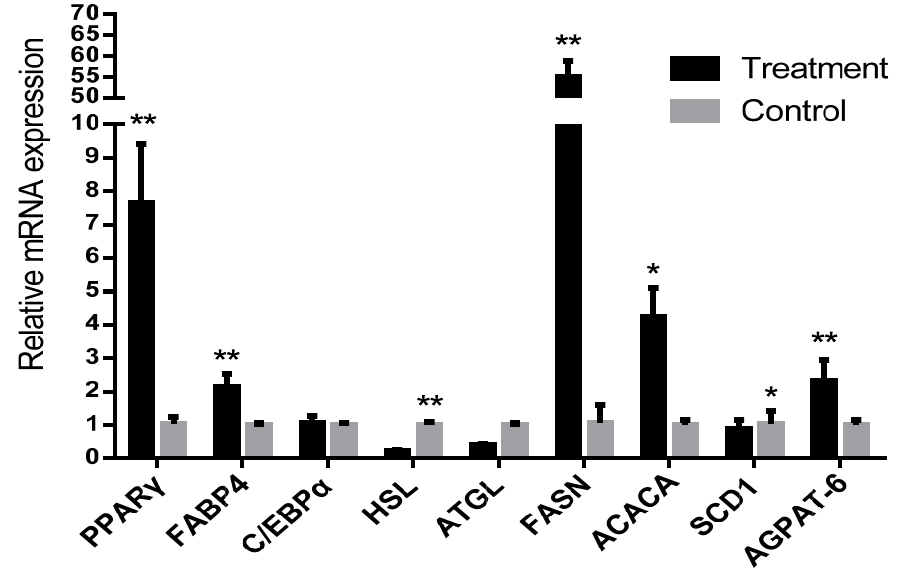
Figure 2. Relative mRNA expressions of lipid metabolism-related genes were normalized to 18s gene expression. The data has been shown as the mean±standard error of six replicates, * and ** mean values within different letters were significantly different (p<0.05) and (p<0.01).